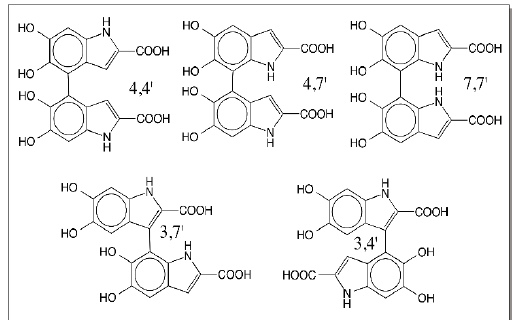
Figure 24. Structure of DHICA dimers. Oxidative polymerization of DHIDA yields 4,4 ′ , 4,7 ′ and 7,7 ′ coupled DHICA dimers as the major products and 3,4 ′ and 3,7 ′ coupled dimers as the minor products.